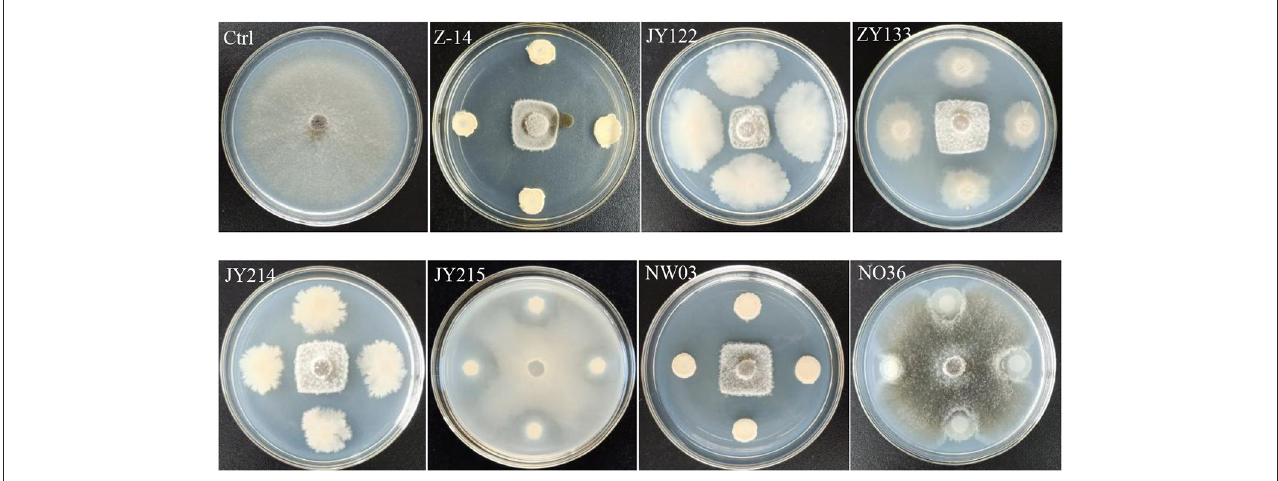
FIGURE1 Antagonistic effect of the selected bacteria strains against Ggt . The Ggt were inoculated in the center of PDA plate, and the strains to be tested were inoculated around the Ggt -inoculation sites.